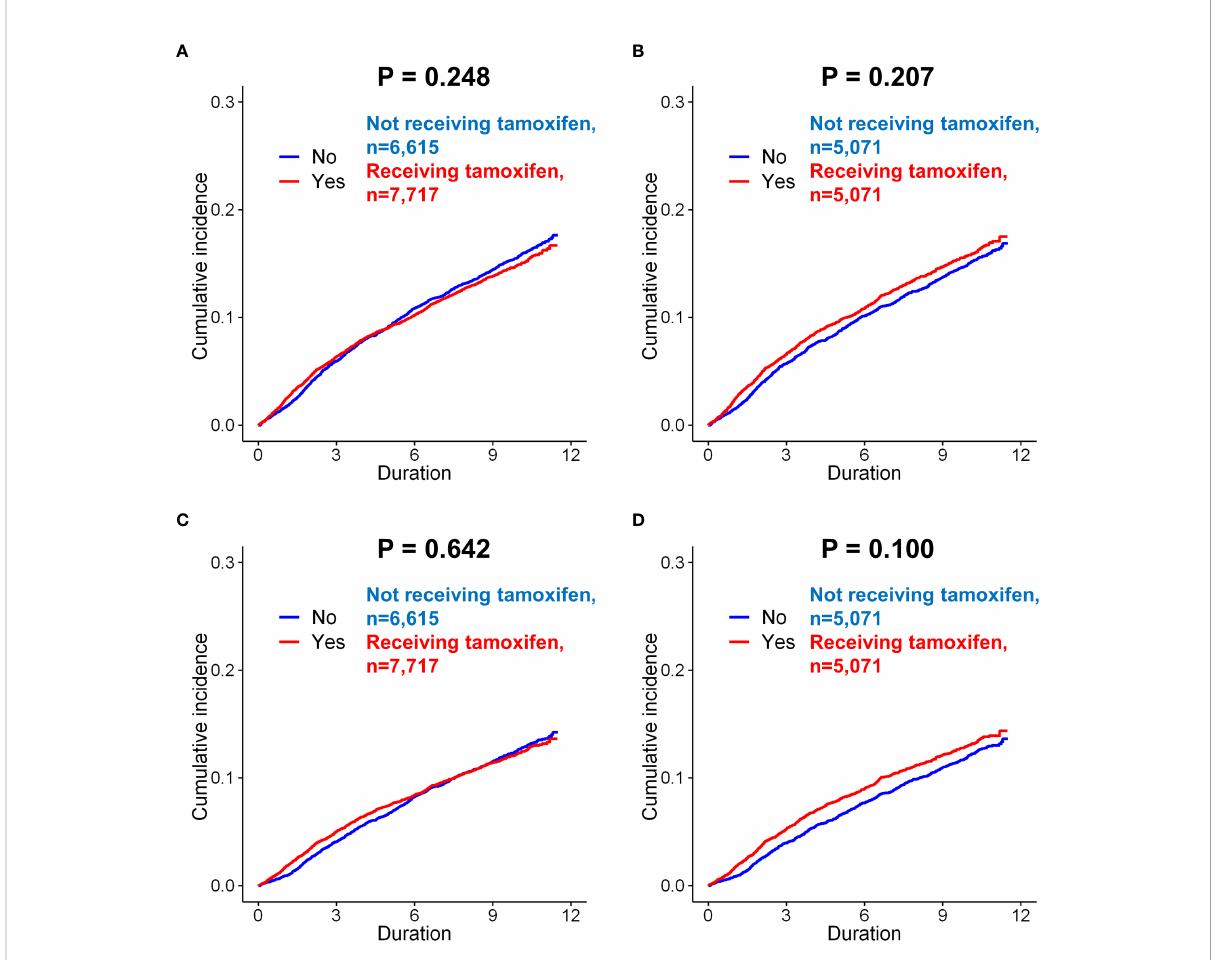
FIGURE 3 Subgroup analysis of incidence of depression in breast cancer patients according to the use of tamoxifen. Before matching, there was no difference in the incidence (only diagnosis) between the patients administered tamoxifen and those not administered tamoxifen (A , p = 0.248, log-rank test ) . After matching, there was still no signi fi cant difference between these two groups (B , p = 0.207 ) . When the incidence of depression (diagnosis + anto-depressant) analyzed in patients, there was no difference in the risk of depression according to tamoxifen use, both before matching (C , p = 0.642 ) and after matching (D , p = 0.100 )